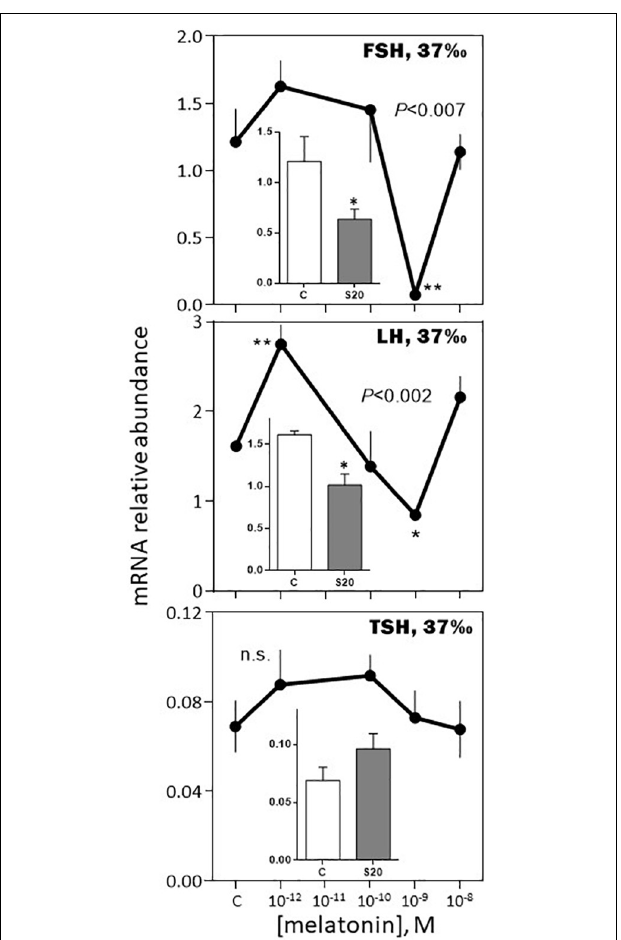
FIGURE 10 | Effects of melatonin and melatonin analogs on FSH, LH and TSH mRNA relative abundance in vitro . Mean ± S.E.M. of n = 3 pools (containing 5 glands each). One-Way ANOVA ( P gives the level of significance; n.s.: non-significant). Means were compared to the corresponding control using the Holm-Sidak’s post hoc test: * P < 0.05, ** P < 0.005. The insets show the 12 h effects of two melatonin analogs S20304 (S20 at 10 – 8 M) and luzindole (Luz at 10 – 7 M). Mean ± S.E.M. of n = 3 pools (containing 5 glands each). Values are compared to the controls using the Student’s t -test at P < 0.01. See Figure 9 for more